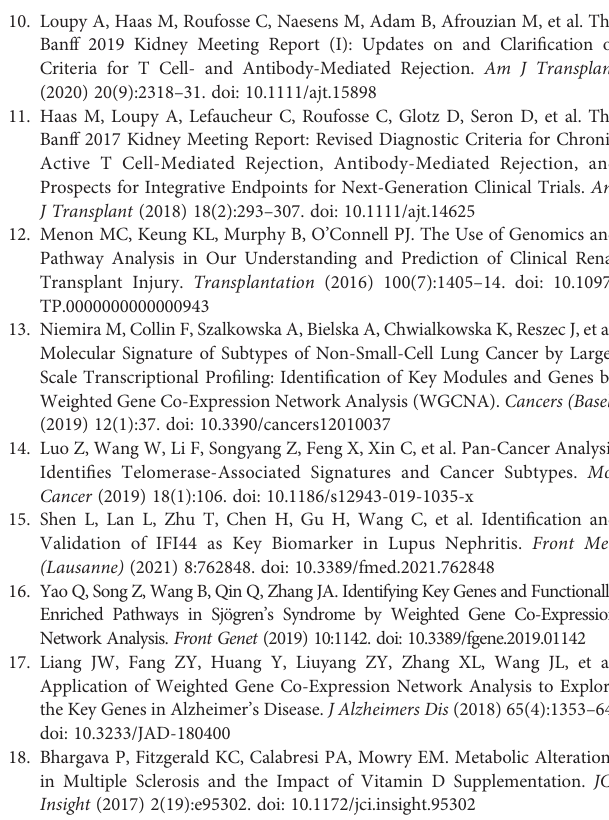
Supplementary Table 1 | DEGs in GSE138043. Supplementary Table 2 | The MCC values of the top 10 genes in the green module. Supplementary Table 3 | Cell-type enrichment score. Supplementary Table 4 | All primer